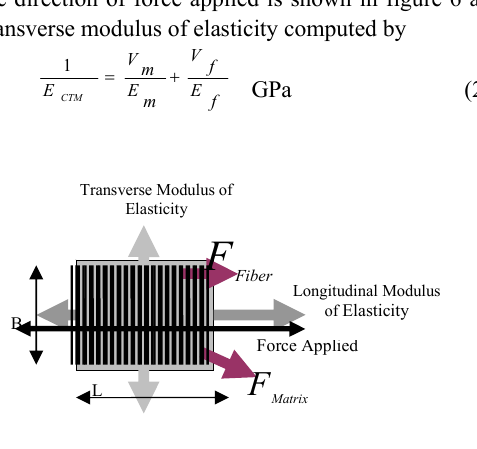
Figure 6: Composite structure having aligned fibers with orientation at 90 0 along the direction the force